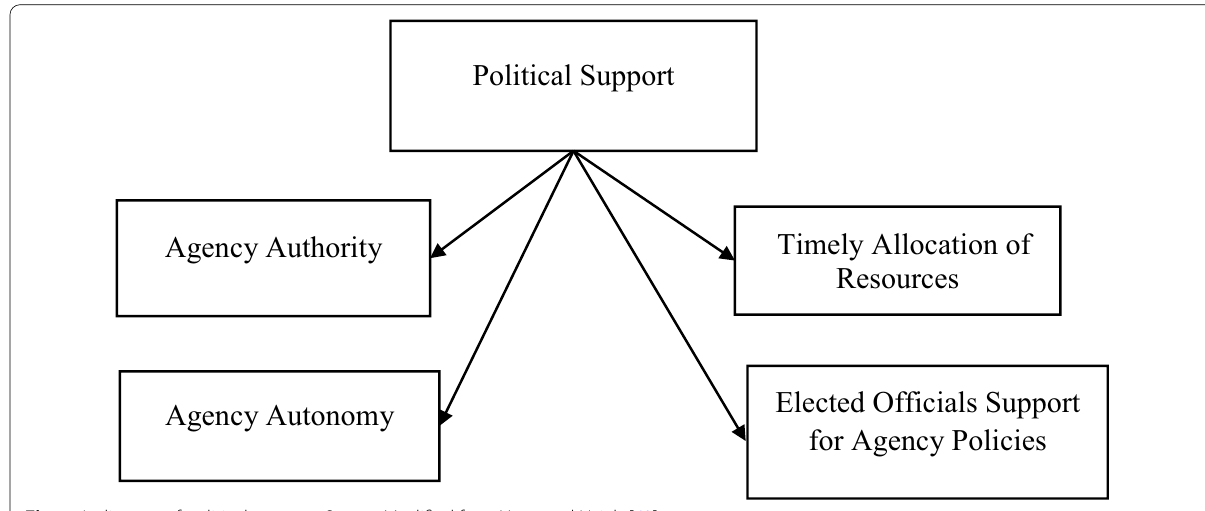
Fig. 1 Indicators of political support. Source : Modified from Yang and Hsieh